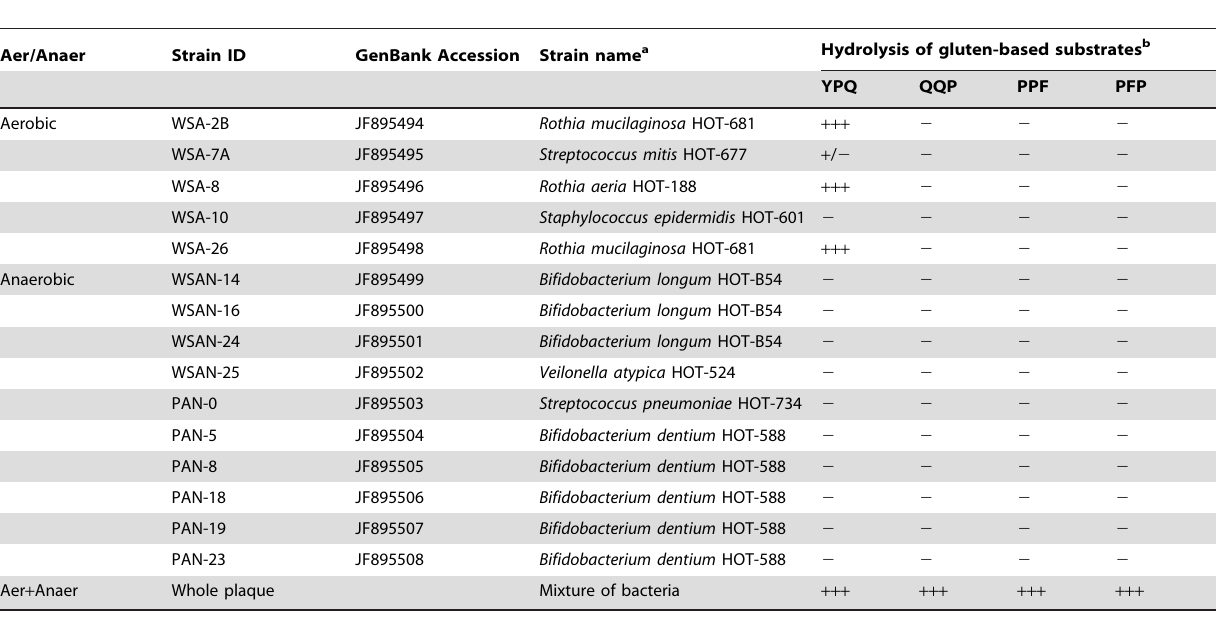
Table 1. Enzymatic characteristics of selected oral microorganisms cultured on gluten agar.